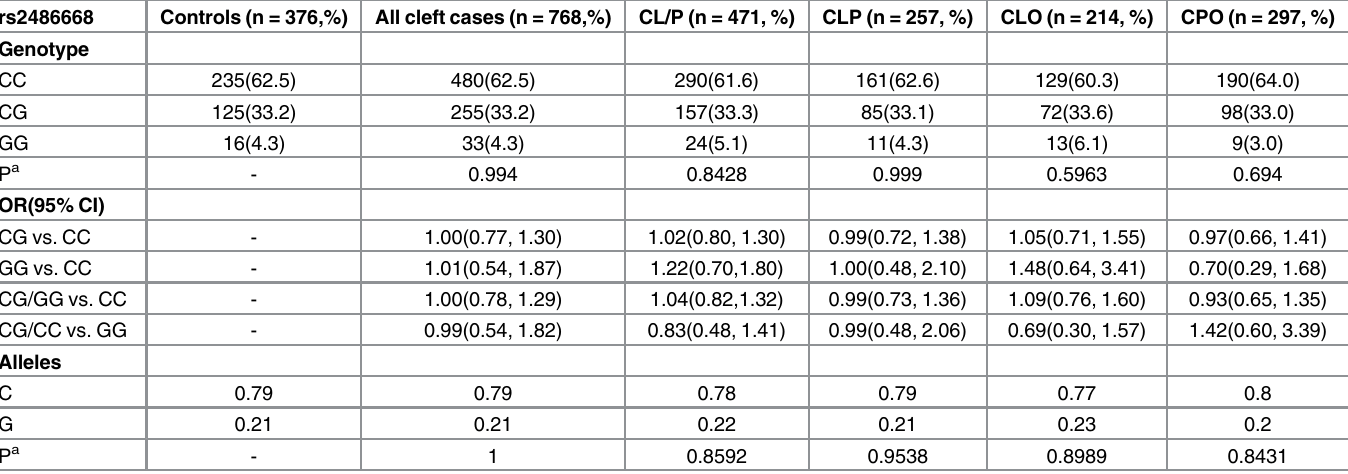
Table 2. Genotypic and allelic distributions of rs2486668 in NSOFC cases and controls.